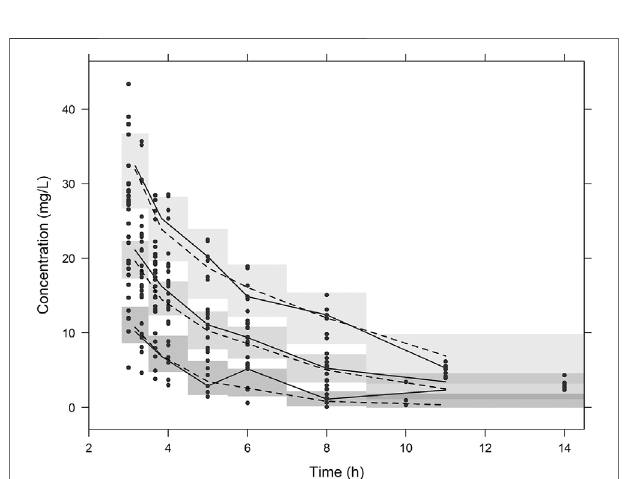
FIGURE 2 | Visual predictive check plots. Plots from simulated concentrations of 1,000 virtual datasets: closed circles (cid:1) observed concentrations; solid lines (cid:1) 10th, 50th, and 90th percentiles of observations; dashed lines (cid:1) 10th, 50th , and 90th percentiles of simulated concentrations; shaded areas (cid:1) 95% con fi dence intervals for the 10th, 50th, and 90th percentiles of simulated concentrations. FIGURE 3 | Probabilities of target attainment of empirical therapy by